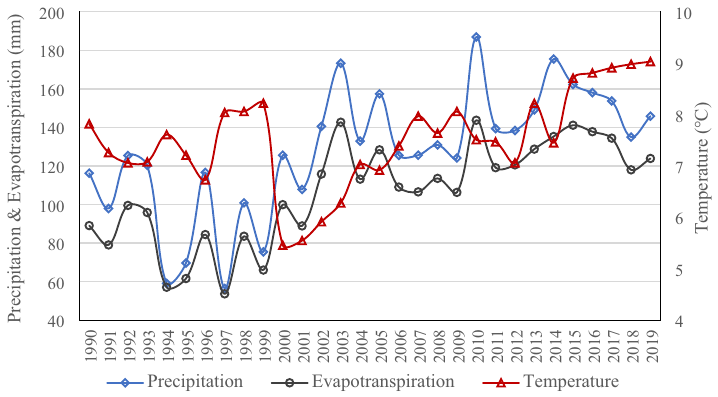
Figure 4. Change trends of annual precipitation, evapotranspiration, and average temperature from 1989 to 2019.